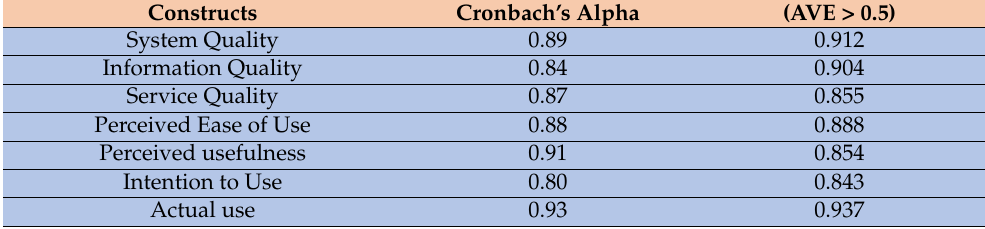
Table 4. Reliability and convergent validity analyses.